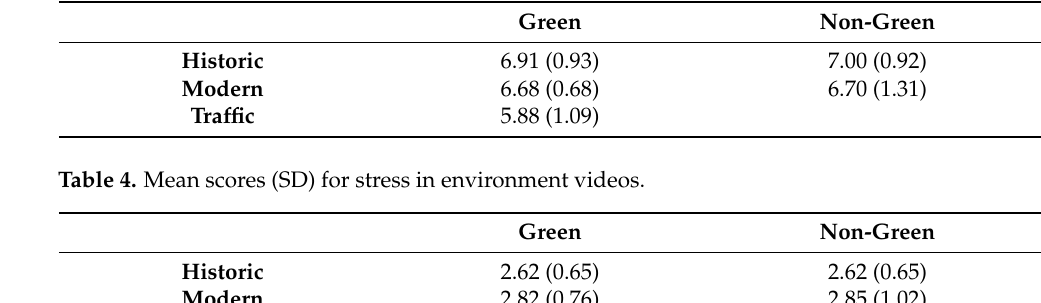
Table 3. Mean scores (SD) for hedonic tone in environment videos.